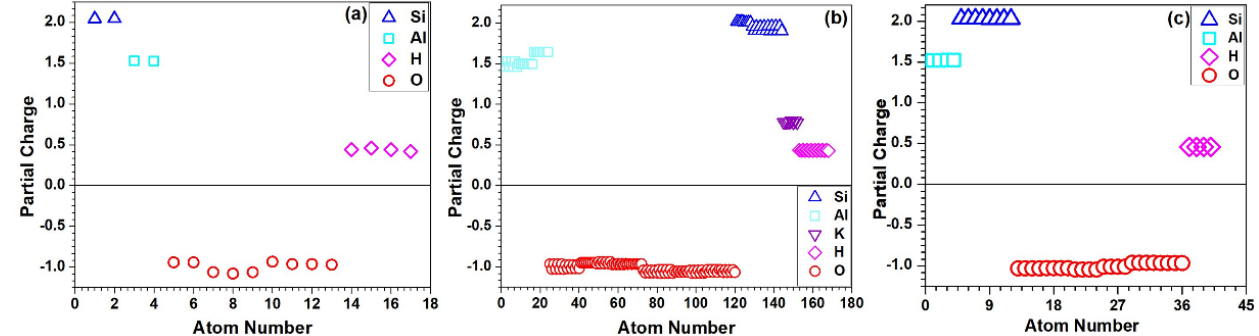
Figure 5. Distribution of partial charge ∆ Q* for ( a ) kaolinite, ( b ) muscovite, and ( c ) montmorillonite.